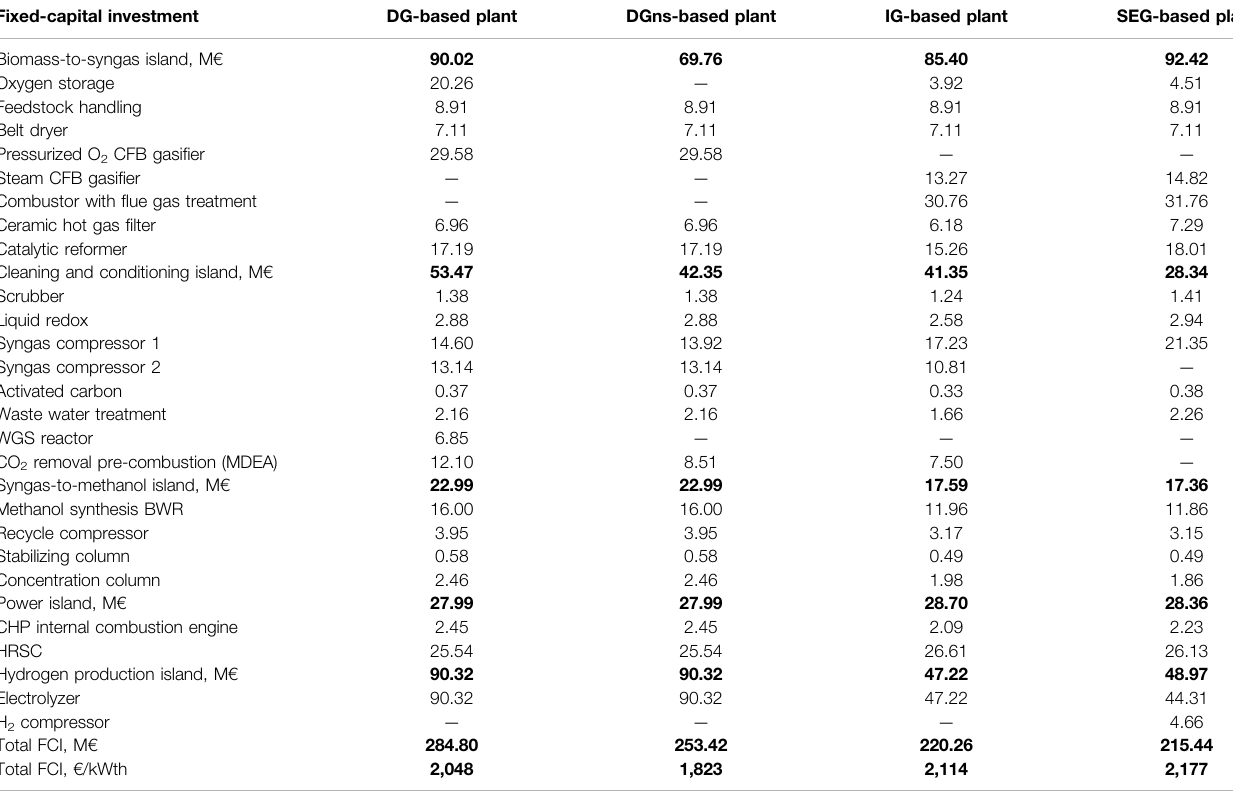
TABLE9| Fixed-capitalinvestmentcostsoftheunitsofthePBtMplants.Numbersinboldarethesumofaseriesofvalues:example:powerisland:27.99=2.45+25.54(CHP ICE+HRSC).